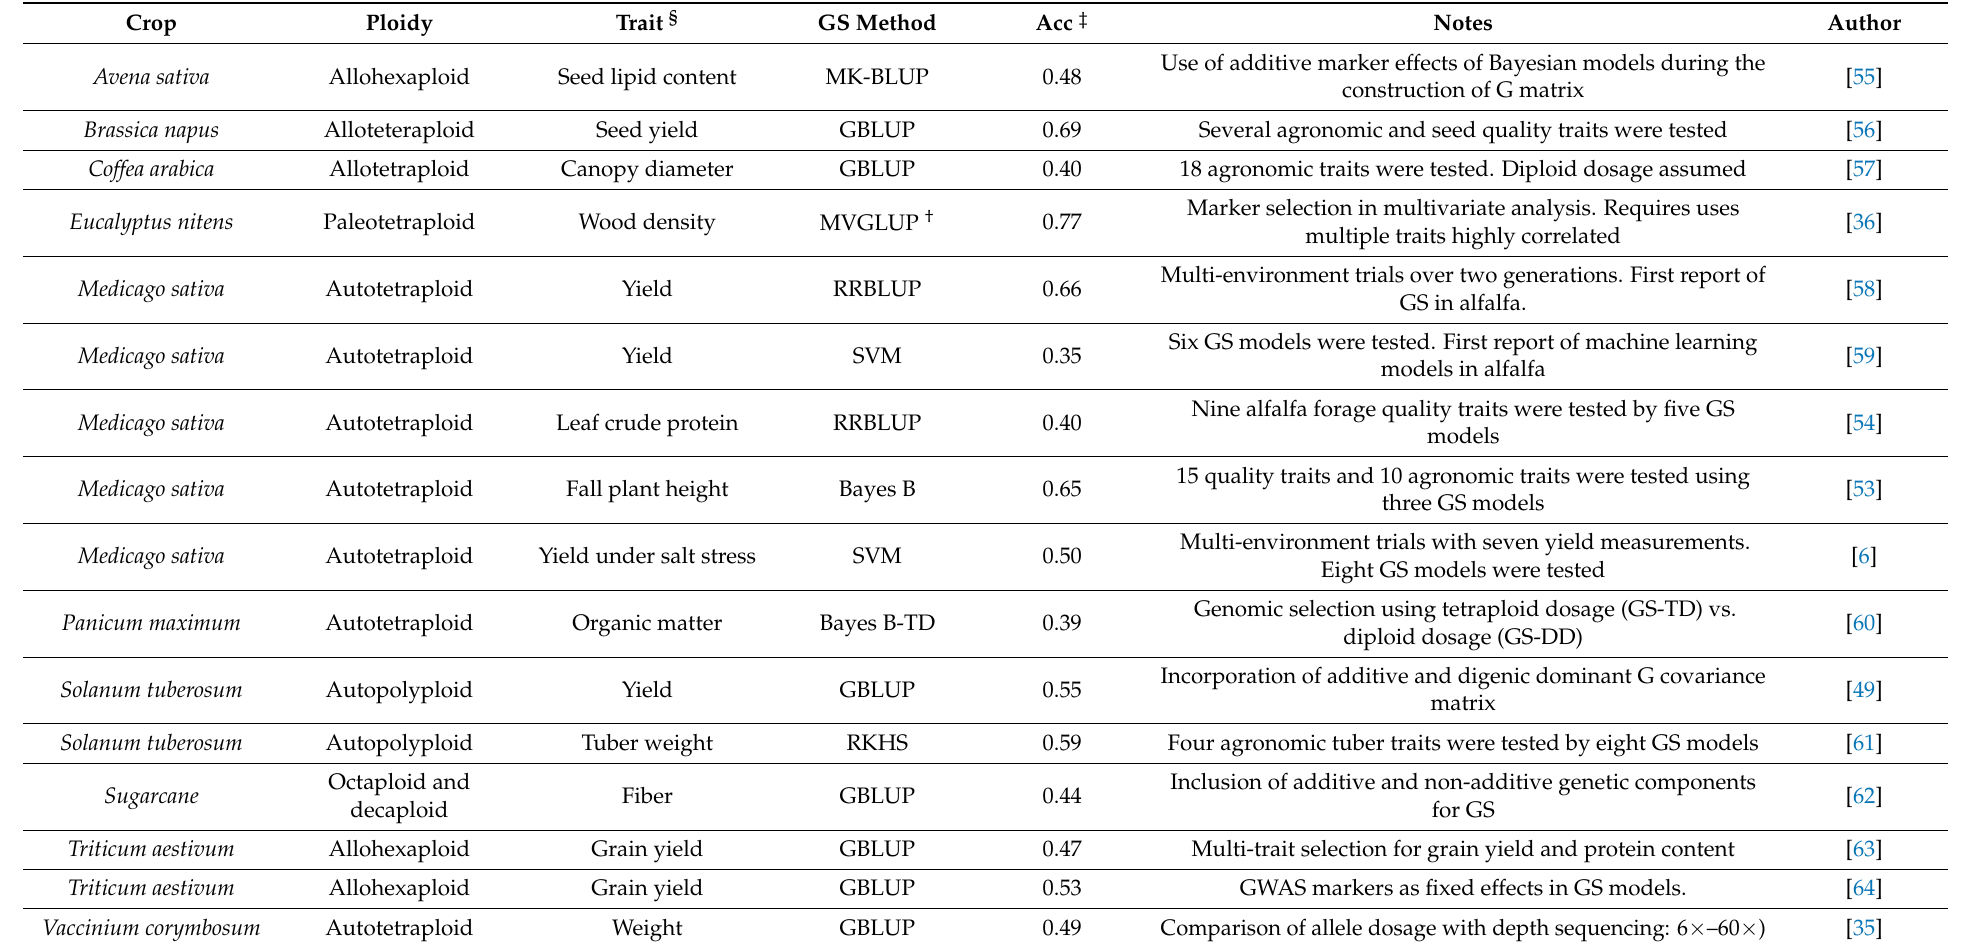
Table 4. Recent achievements in genomic selection (GS) in polyploid